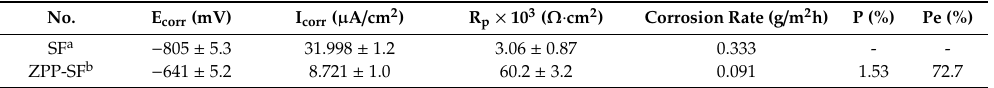
Table 2. The results of potentiodynamic corrosion tests.